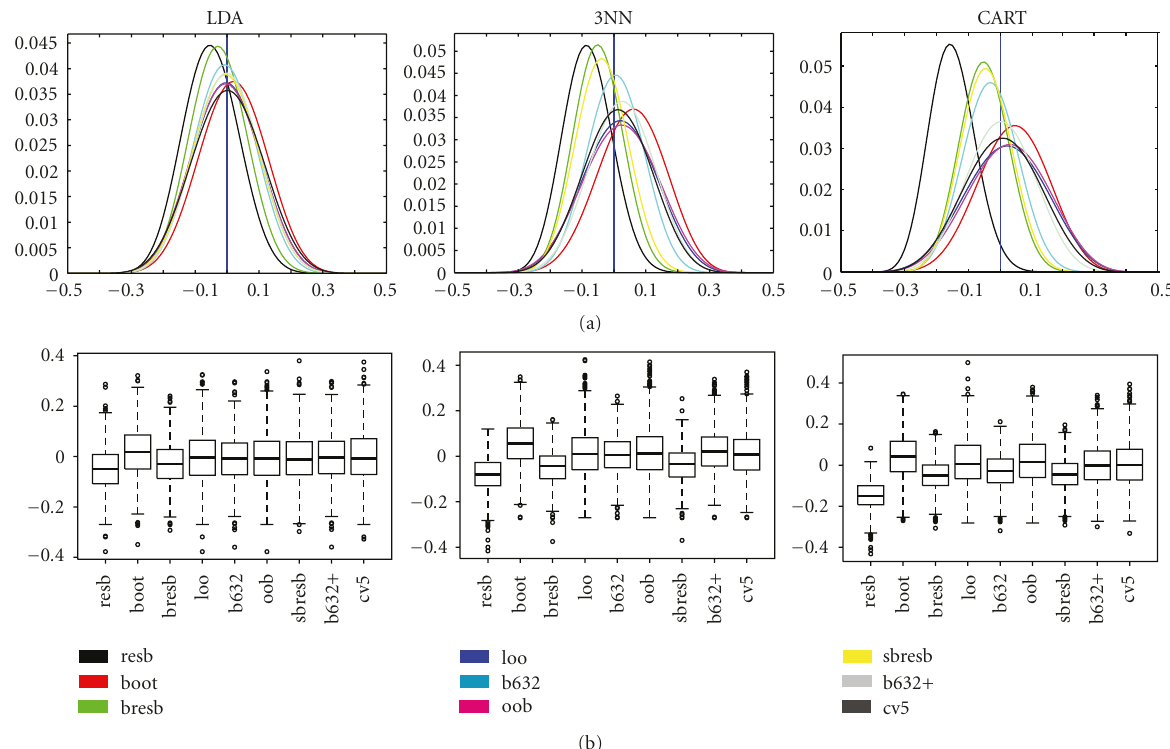
Figure 7: Empirical deviation distribution (a) and box plots (b), for prostate cancer mass-spectrometry data, sample size n = 20, and dimensionality p = 2, with di ff erent base classification